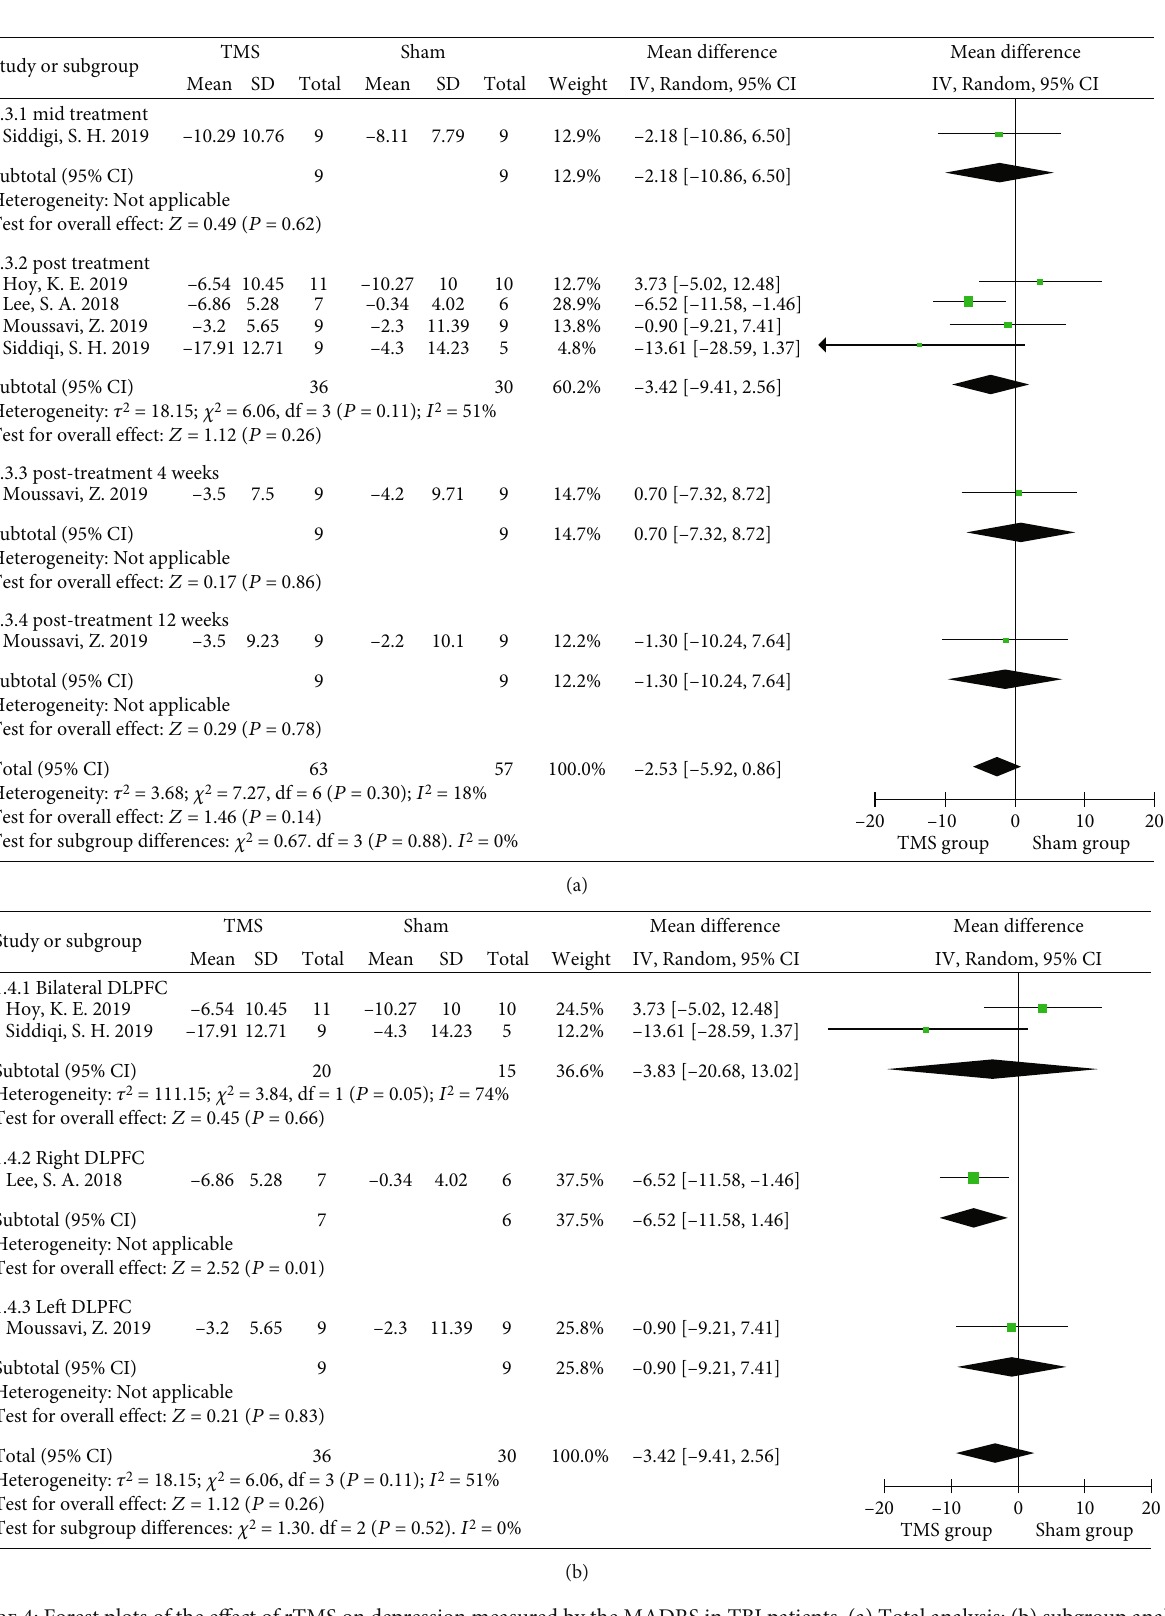
Figure 4: Forest plots of the e ff ect of rTMS on depression measured by the MADRS in TBI patients. (a) Total analysis; (b) subgroup analysis of posttreatment e ff ectiveness. DLPFC: dorsolateral prefrontal cortex; MADRS: Montgomery-Asberg Depression Rating